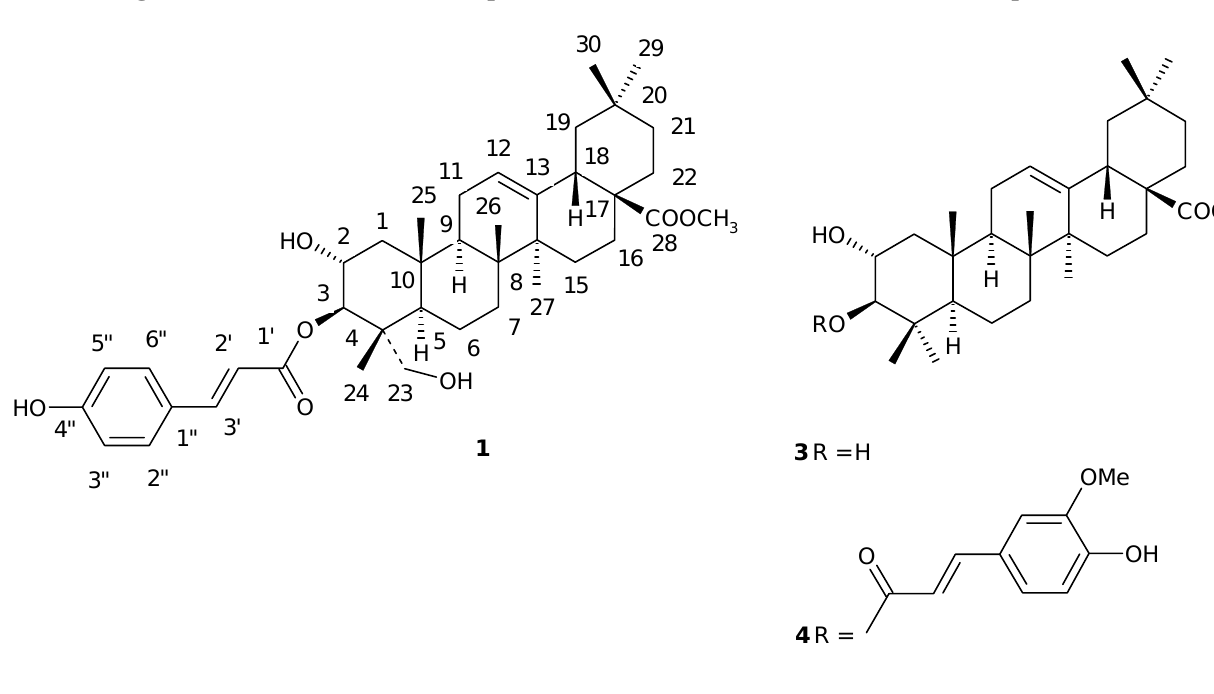
Figure 2. Structures of the compounds (1, 3 and 4) isolated from Microcos